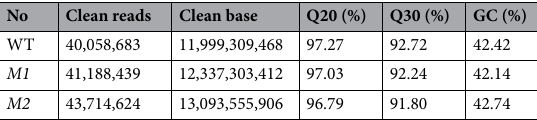
Table 5. Sequencing data evaluation